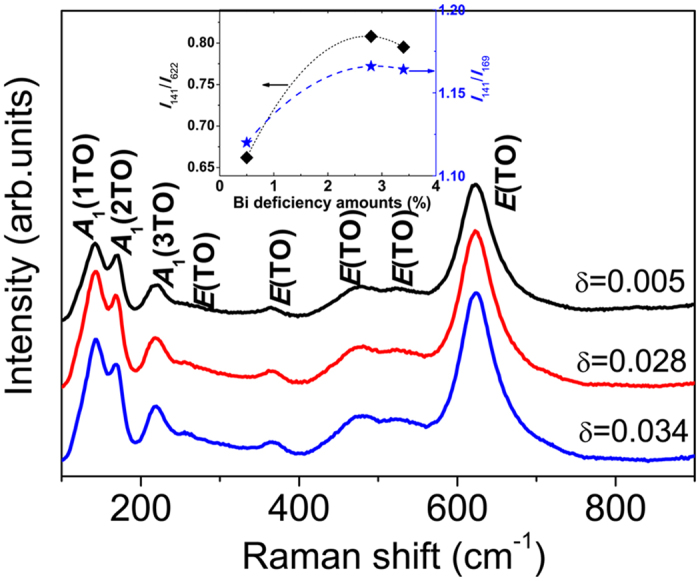
Raman spectra of Bi1-δFe0.95Mn0.05O3 films with different δ concentrations.The inset shows the change of intensity ratios of Raman vibrational modes at 141 cm−1 with 622 cm−1 and 169 cm−1, respectively, with Bi deficiency concentrations.